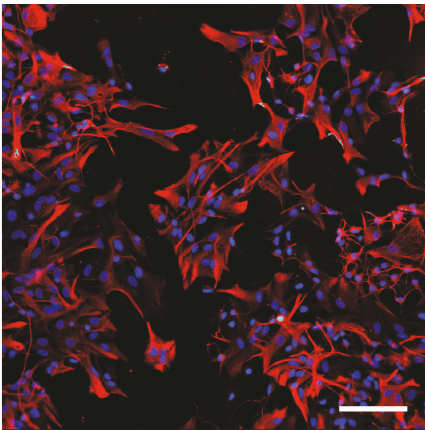
Figure 2: Representative immunohistochemical staining for GFAP (astrocyte, red), CD11b (microglia, green), and DAPI staining (nuclei, blue) in rat primary cortical astrocytes. Scale bar = 20 𝜇